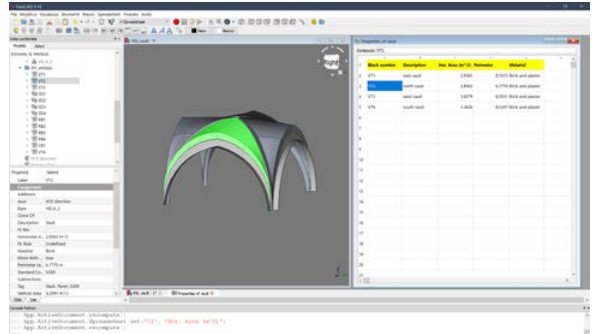
Figure 14. CSV spreadsheet referred to the rib vault properties inside